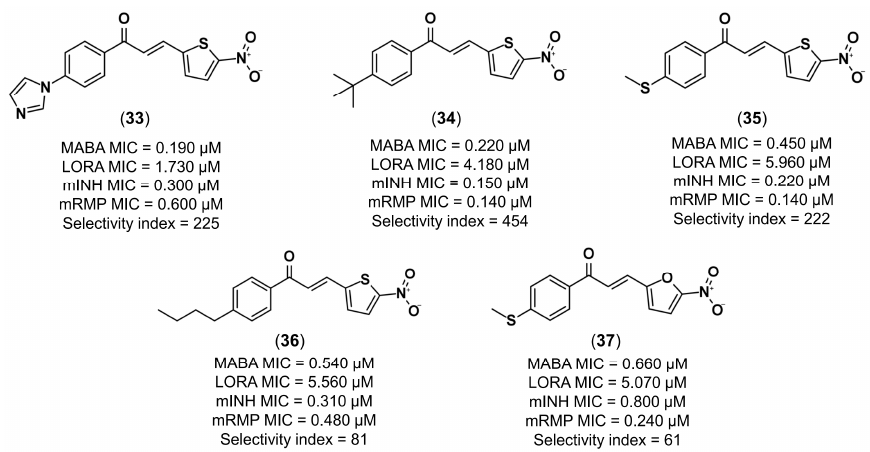
Figure 12. Antitubercular 5-nitro-substituted heteroaryl chalcones prioritized by our QSAR-driven drug design strategy [139].